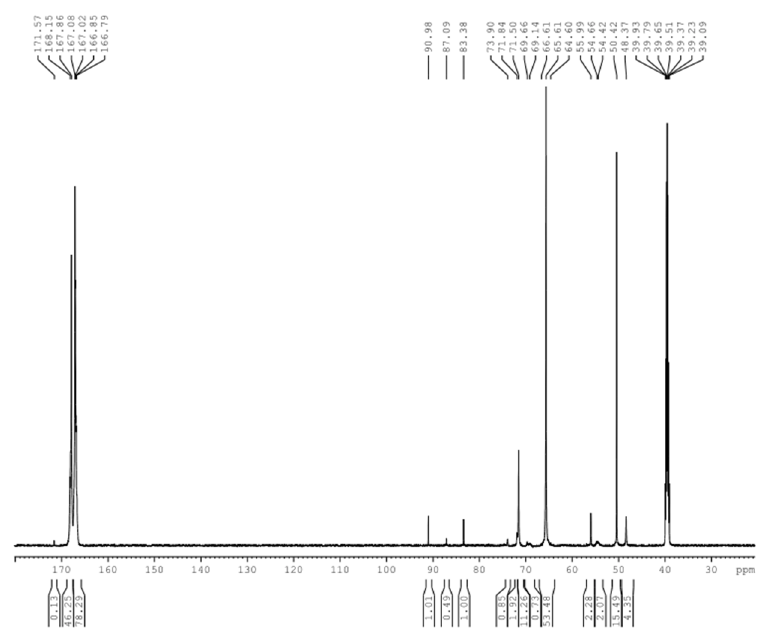
Figure 6. The 13 C-NMR spectrum of sample B.